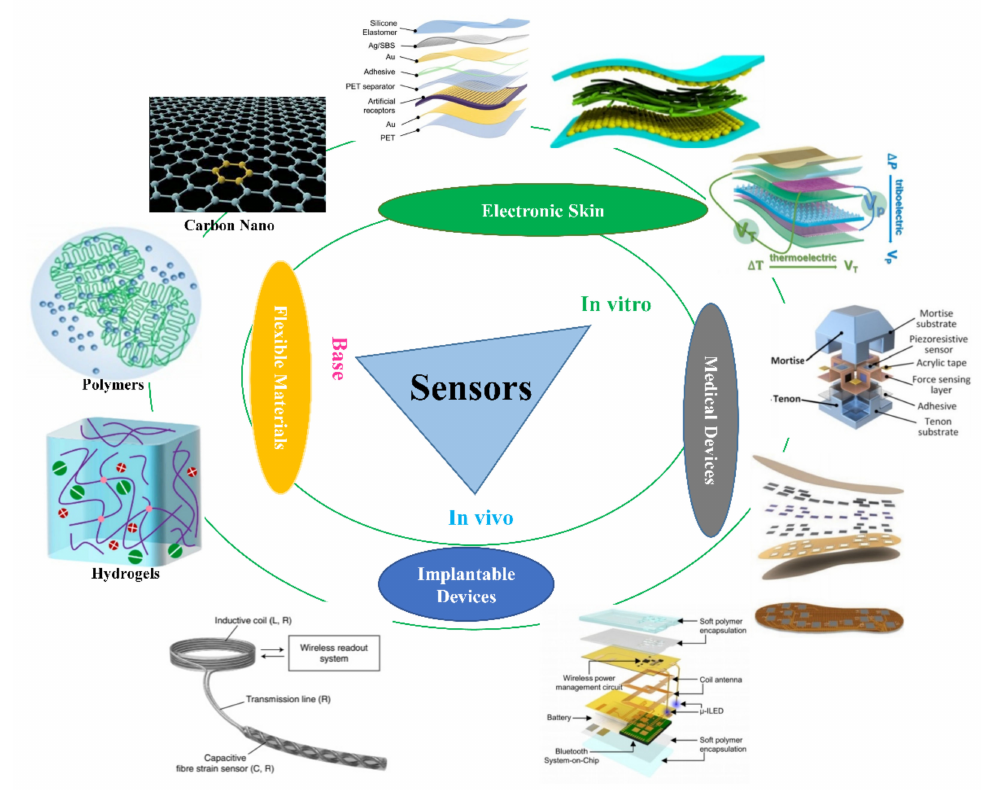
Figure 1. Overview of research in flexible wearable sensor devices for biomedical